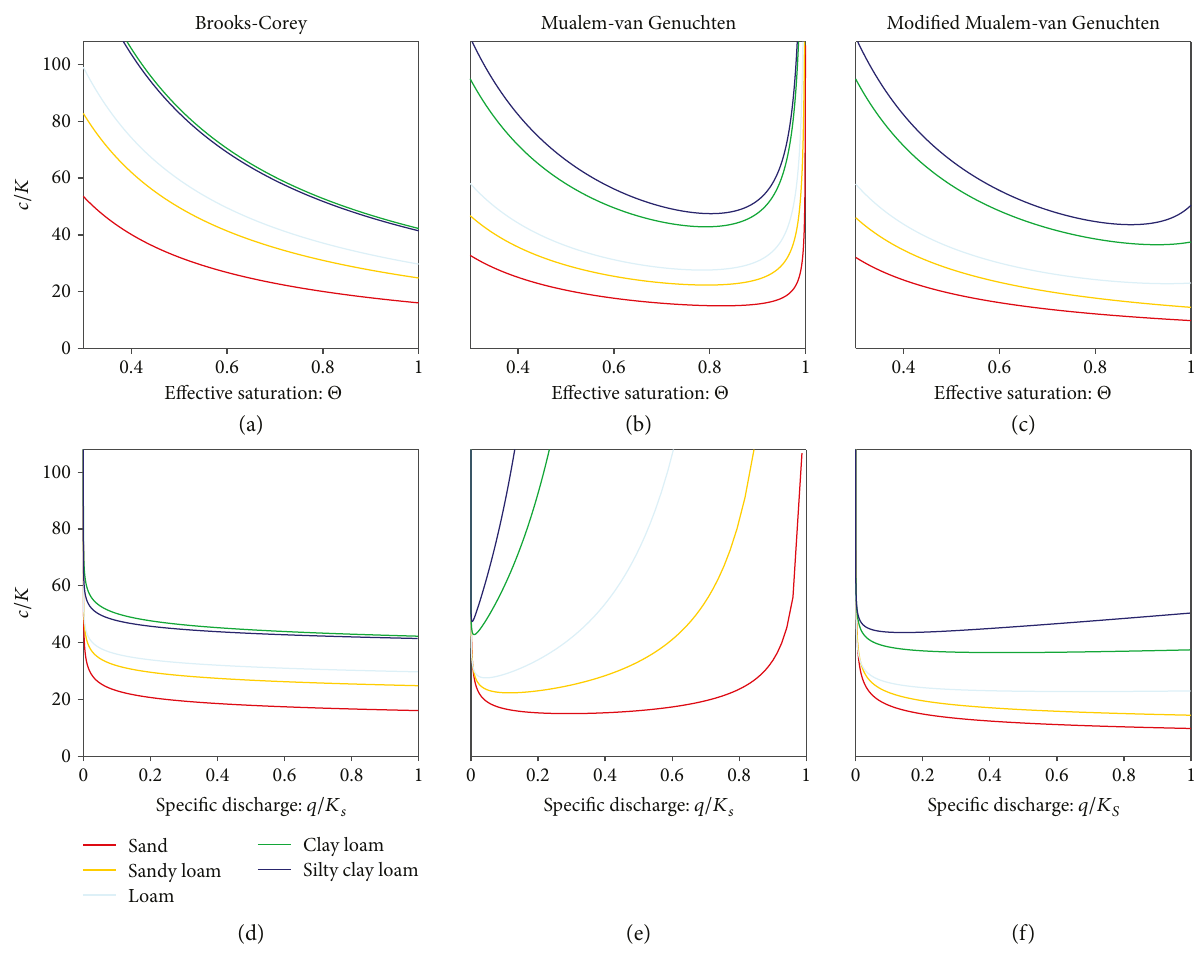
Figure 9: Under 3 models (illustrating in each column), (a – c) the relation between the ratio of c / K with e ff ective saturation Θ and (d – f) the relation between the ratio of c / K with relative speci fi c discharge q / K s are